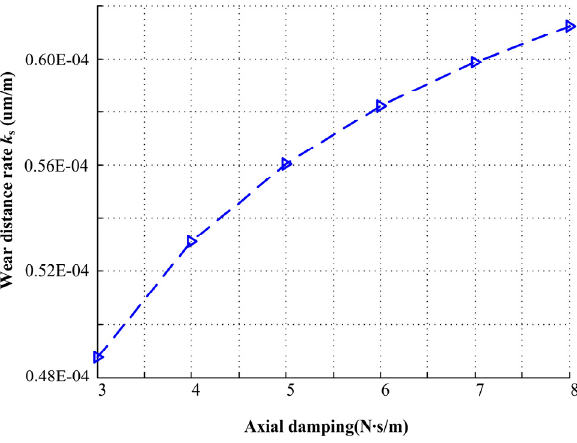
Figure 15. Wear distance rate under different axial damping.